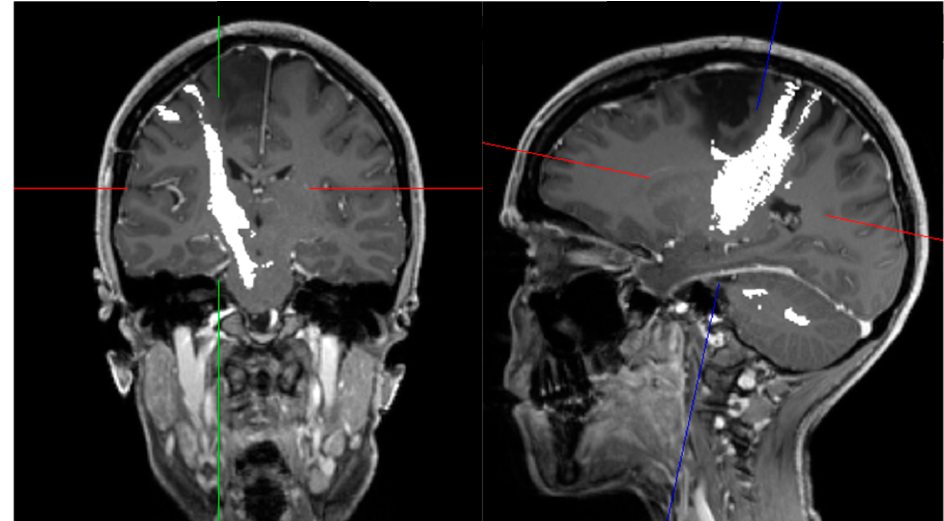
Figure 6. Diffusion tensor imaging fiber tracking showing the right pyramidal tract of a patient with precentral brain tumor. Coronal view ( left ); sagittal view ( right ).